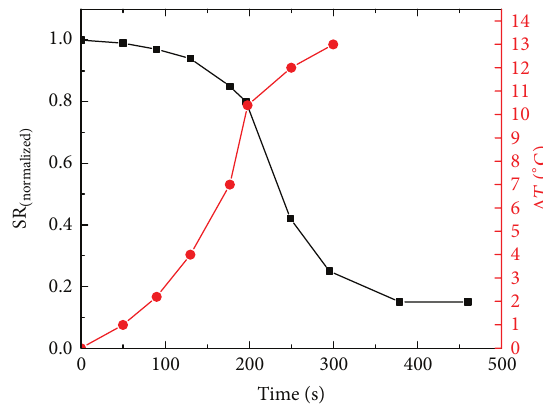
Figure 4: Swelling/deswelling ratio (normalized) of MTNs as a response to an alternating magnetic field (AMF) (black). The sharp decrease at around 200 seconds corresponds to the time at which the LCST is reached. Temporal variation of the average temperature of the particle caused by the heat produced in the NBs, when the AMF is on